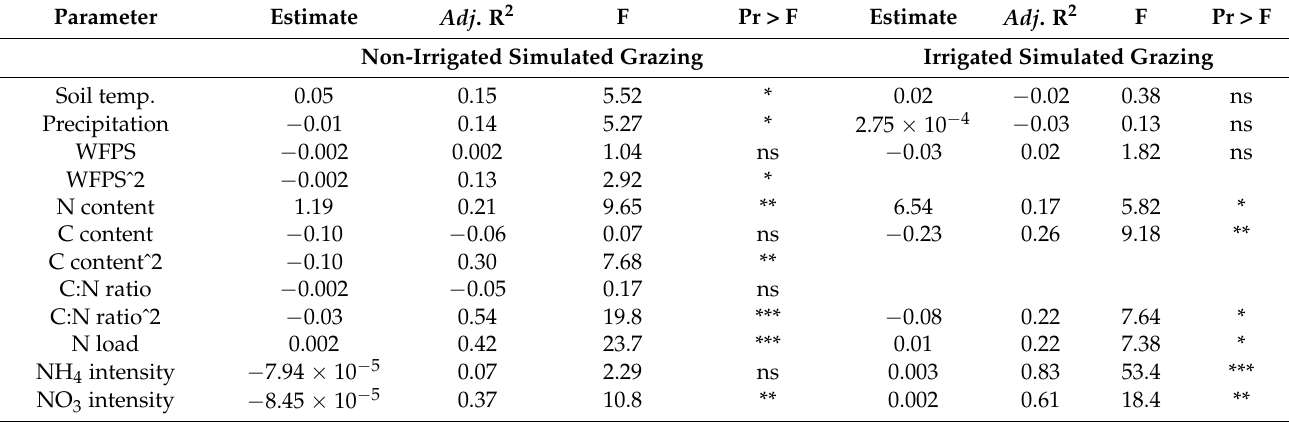
Table A3. Bivariate relationships between N 2 O-N emission factors and the measured/estimated